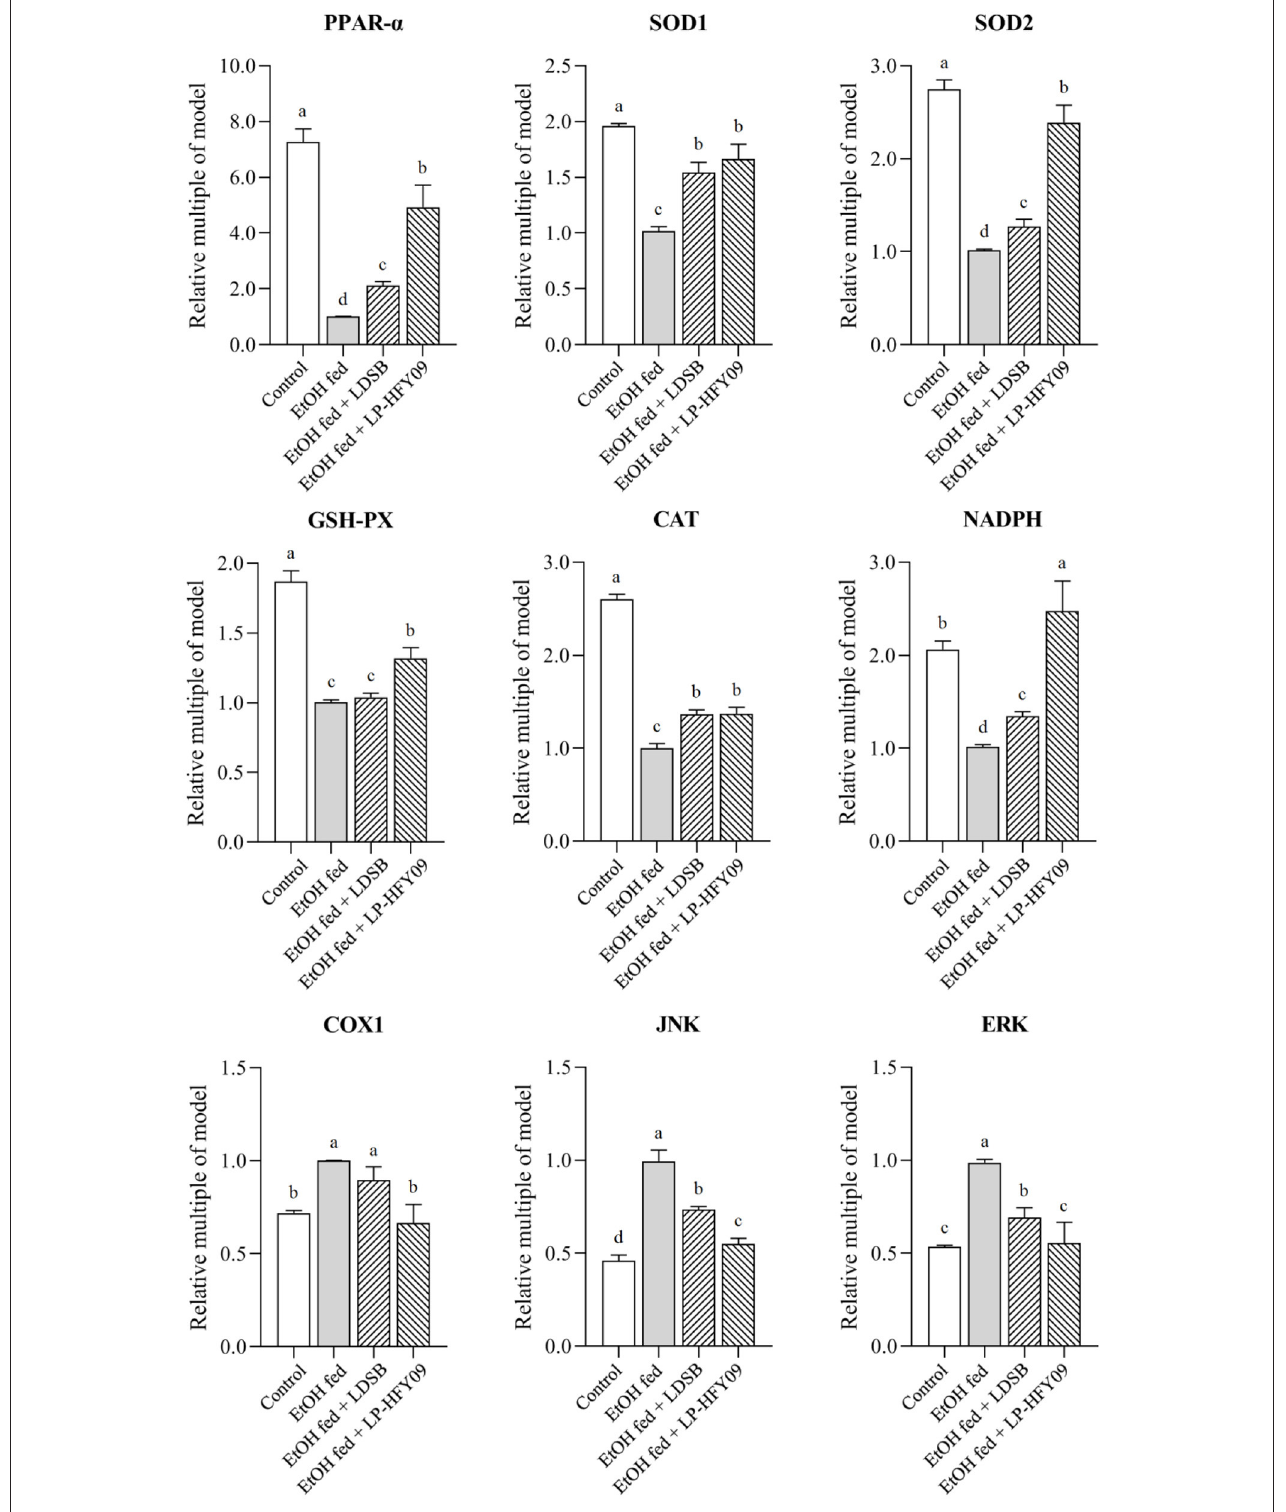
FIGURE 4 | mRNA expressions in hepatic tissue of mice; peroxisome proliferator-activated receptor alpha (PPAR- α ), superoxide dismutase 1 (SOD1), superoxide dismutase 2 (SOD2), and glutathione-peroxidase (GSH-PX), catalase (CAT), nicotinamide adenine dinucleotide phosphate (NADPH), cyclooxygenase-1 (COX1), c-Jun N-terminal kinase (JNK), and extracellular regulated protein kinases (ERK). a − d The different letters mean that there are significant differences ( p < 0.05) between every